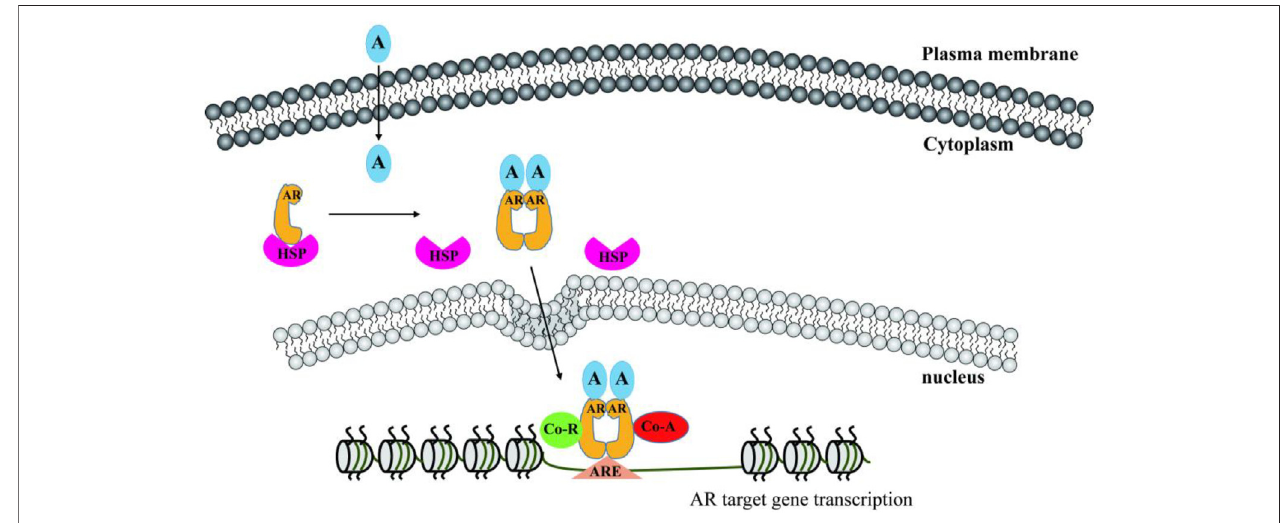
FIGURE 1 | Androgen/AR signaling pathway. A, androgen; AR, androgen receptor; HSP, heat shock protein; ARE, androgen response element; Co-R, co- repressor; Co-A,